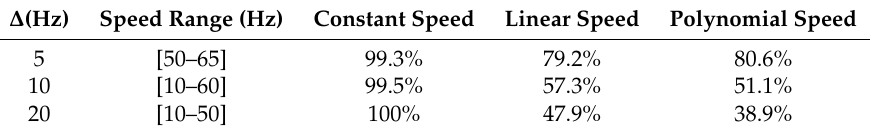
Table 3. Accuracy of the SVMs with respect to discretization of the speed